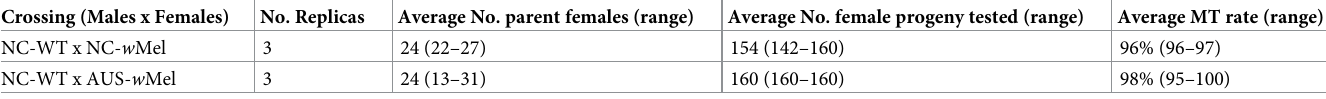
Table 3. Maternal transmission of Wolbachia from progeny of infected females crossed with uninfected males. Crossing (Males x Females)